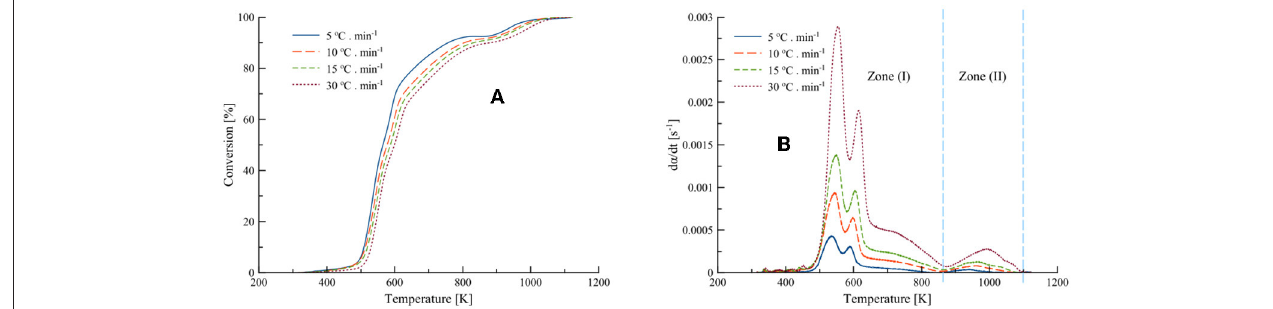
FIGURE 3 | (A) Conversion and (B) DTG curves of Turbinaria ornata at 5, 10, 15, and 30 ◦ C min − 1 .